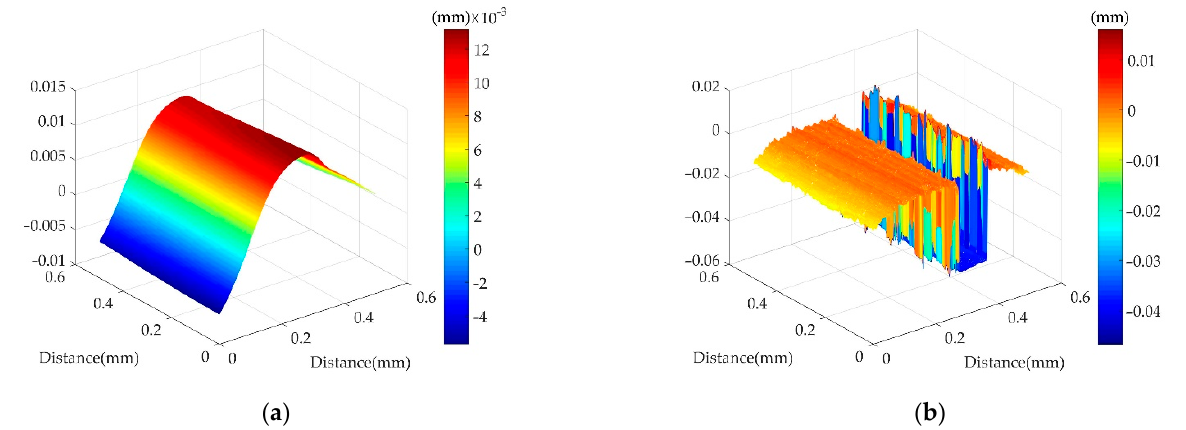
Figure 15. ( a ) Waviness surface and ( b ) roughness surface after using the RGRF filter.